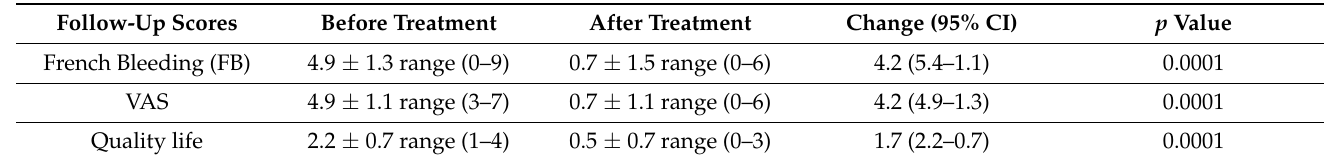
Table 3. Results after 12 months in relation to bleeding (FBS), pain measured using VAS and quality of life